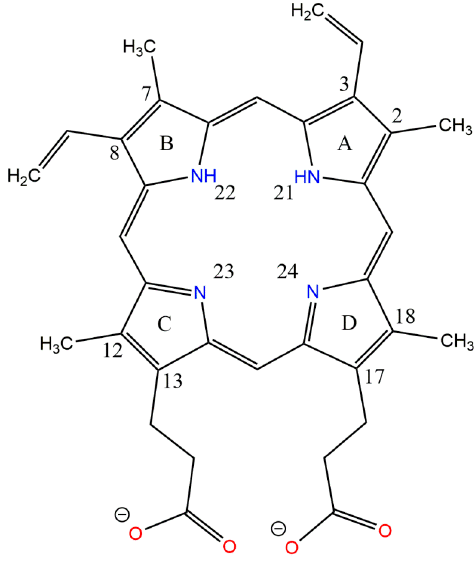
Figure 6. Chemical structure of the dominant PpIX tautomer in aqueous solution at pH 7.4. Atoms and rings are numbered in order of the docking results’ interpretation.